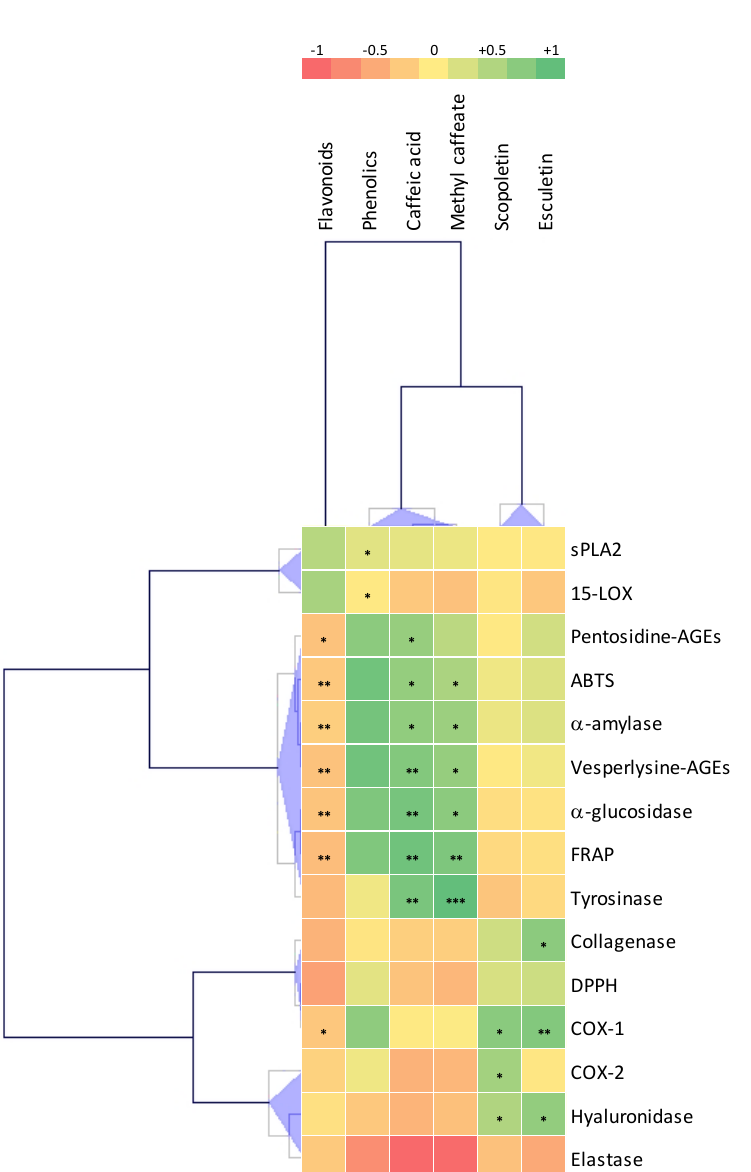
Figure 11. Correlation analysis (PCC) of the relation between the main phytochemicals (caffeic acid, methyl-caffeate, scopoletin, and esculetin) from extracts of in vitro culture of S. xanthocarpum subjected to different light treatments and the mentioned biological activities (antioxidant, anti-diabetes, and anti-inflammatory). Significance level: * p < 0.05, ** p < 0.01, *** p < 0.001. Actual PCC values are indicated in Supplementary Materials Table S1.